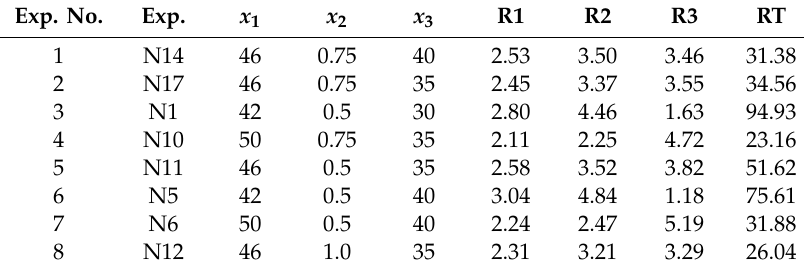
Table 1. Central composite face design and the results of observed responses (critical method attributes,